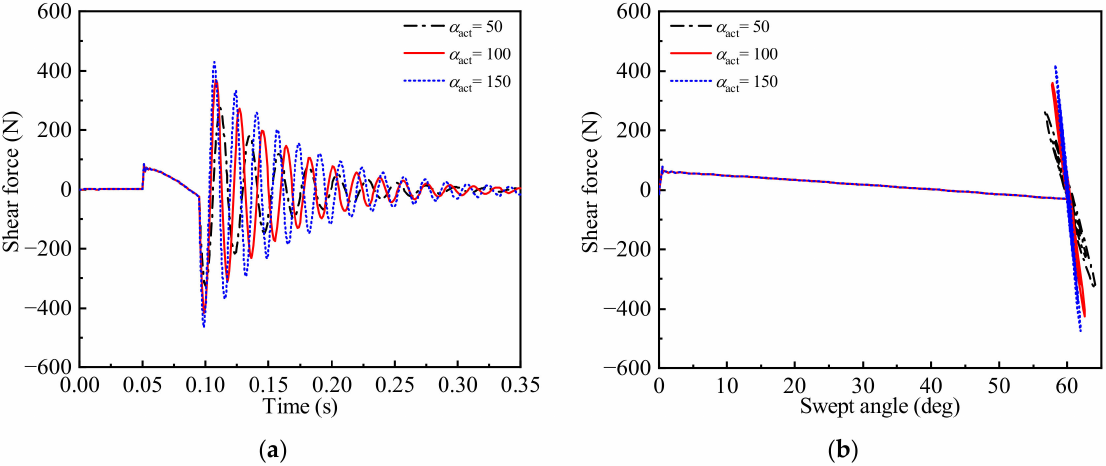
Figure 22. Transient responses of the wing-root shear force. ( a ) Shear force vs. time. ( b ) Shear force vs. sweep angle.